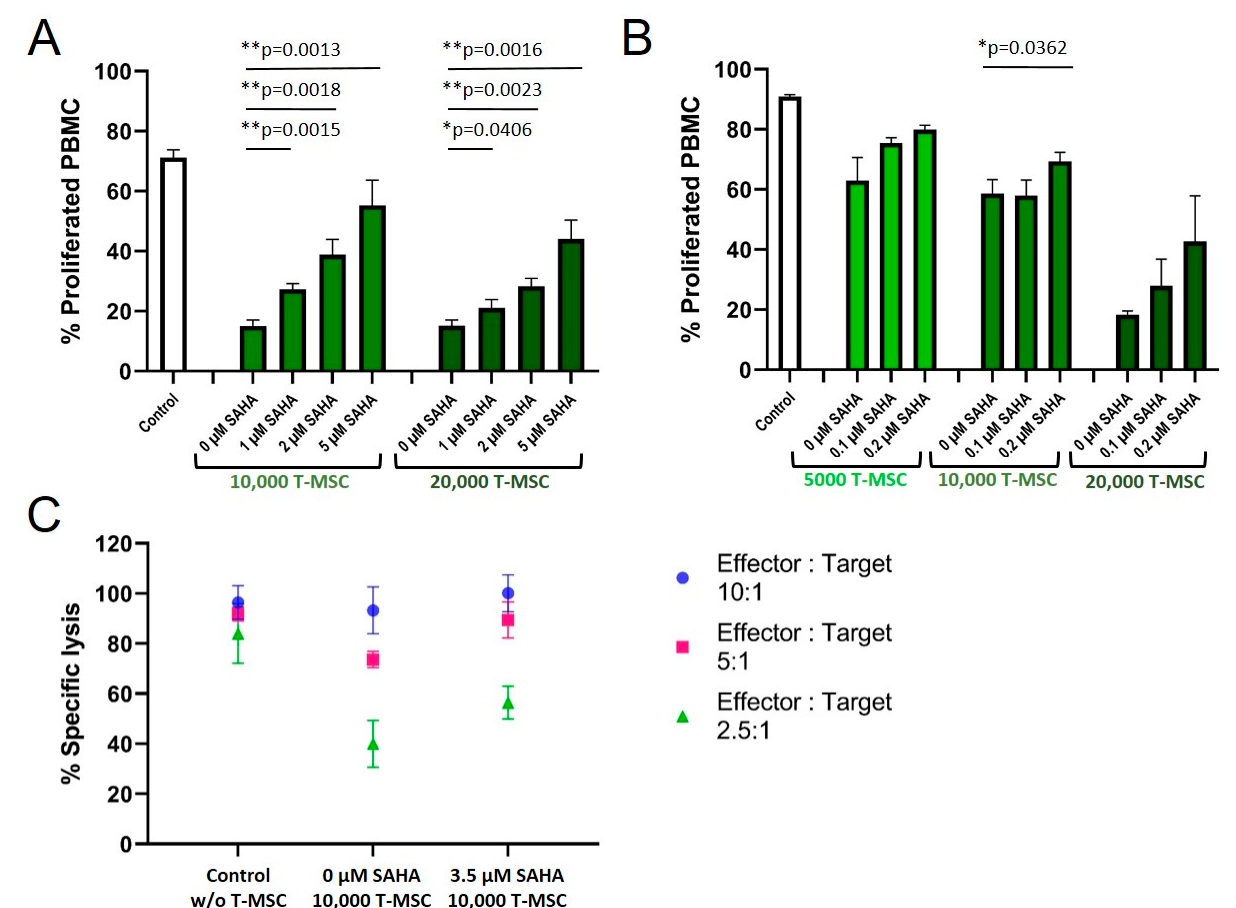
Figure 5. SAHA treatment partially reduced the antiproliferative effects of T-MSC on PBMC. Proliferation of IL-2/OKT3 stimulated PBMC in co-cultures with T-MSC and previously SAHA-treated T-MSC was analyzed by CFSE assays ( A , B ). NK cell cytotoxicity in co-cultures with T-MSC and previously SAHA-treated T-MSC was analyzed by BATDA cytotoxicity assays ( C ). NK cells were isolated from peripheral blood, activated with 100 U/mL IL-2 overnight, and either cultured alone (control), in the presence of control-treated T-MSC or T-MSC that had been previously treated with SAHA for four days. Diagrams show mean and SD, n = 3. * p < 0.05, ** p < 0.01 in an unpaired Student’s t test. PBMC: peripheral blood mononuclear cell, SAHA: suberoylanilide hydroxamic acid; T-MSC: tumor-derived mesenchymal stromal cell.